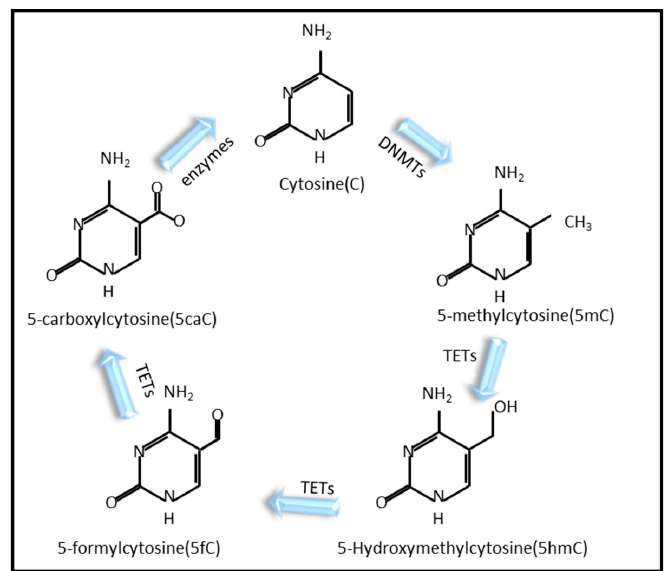
Figure 1. DNA methylation and demethylation. DNA cytosine methylation is catalyzed by DNA methyltransferases (DNMTs) to form 5-methylcytosine (5mC). Then, it can be oxidized iteratively by ten-eleven translocation (TET) protein to develop to 5-hydromethylcytosine (5hmC), 5-formylcytosine (5fC), and 5-carboxylcytosine (5caC), respectively. Finally, 5-carboxylcytosine (5caC) can be demethylated into the cytosine through the catalysis of a series of enzymes. Figure modified from Kohli and Zhang (2013) [17].